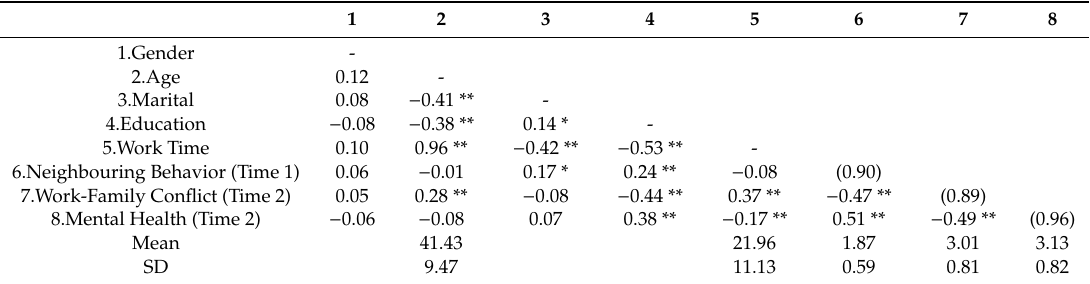
Table 2. Mean, Standard Deviance,